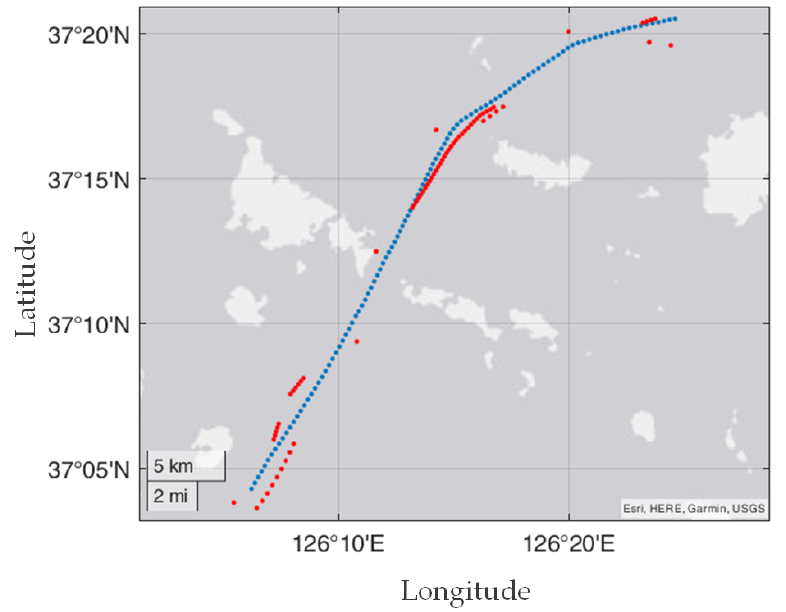
Figure 3. Ship-to-ship situation recognized from the AIS data.